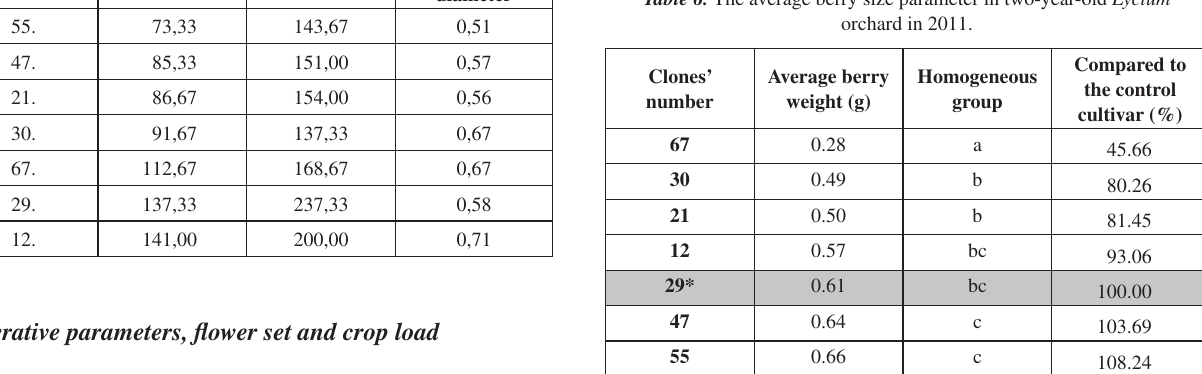
Table 6. The average berry size parameter in two-year-old Lycium